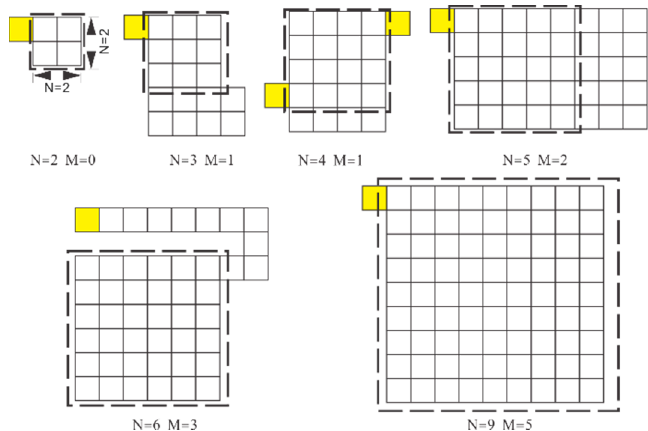
Figure 10. Application of DEDNM to flats with a square area (N = length of the square area; M = repeating times for processing no drainage cells).